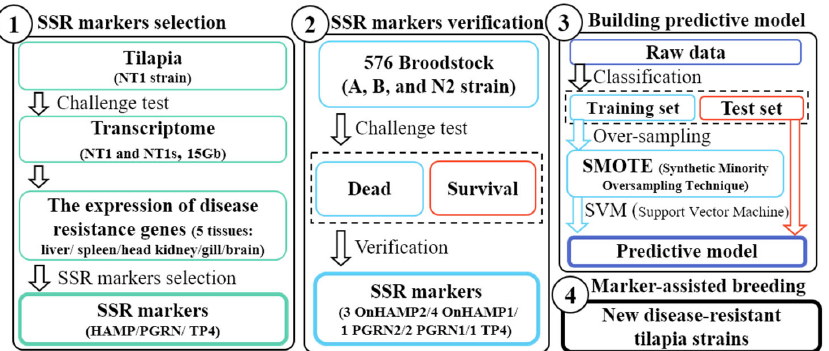
Figure 1. Experimental scheme showing the four main axes in this study. ( 1 ) SSR markers selection: transcriptome data were created by the NT1 strain challenge test, and SSR markers were selected through the transcriptome and gene expression results (NT1: NT1 strain without infection; NT1S: NT1 strain infected by 10 4 CFU/g Streptococcus iniae ). ( 2 ) SSR markers verification: a total of 576 fish from A, B, and N2 strains were infected with S. iniae to verify the association of SSR markers with disease resistance. ( 3 ) Building the predictive model: the raw data from step 2 were over ‐ sampled by SMOTE method (synthetic minority oversampling technique), and then used to establish a pre ‐ dictive model through SVM (support vector machine). ( 4 ) Marker ‐ assisted breeding: establish new disease ‐ resistant tilapia strain by the marker ‐ assisted breeding method.